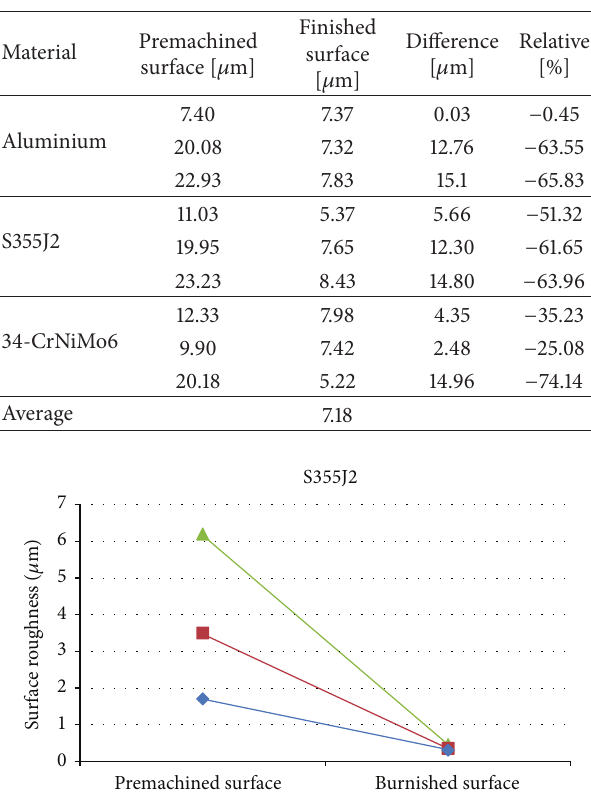
Table 3: Surface roughness results. Table 4: Out-of-roundness results.